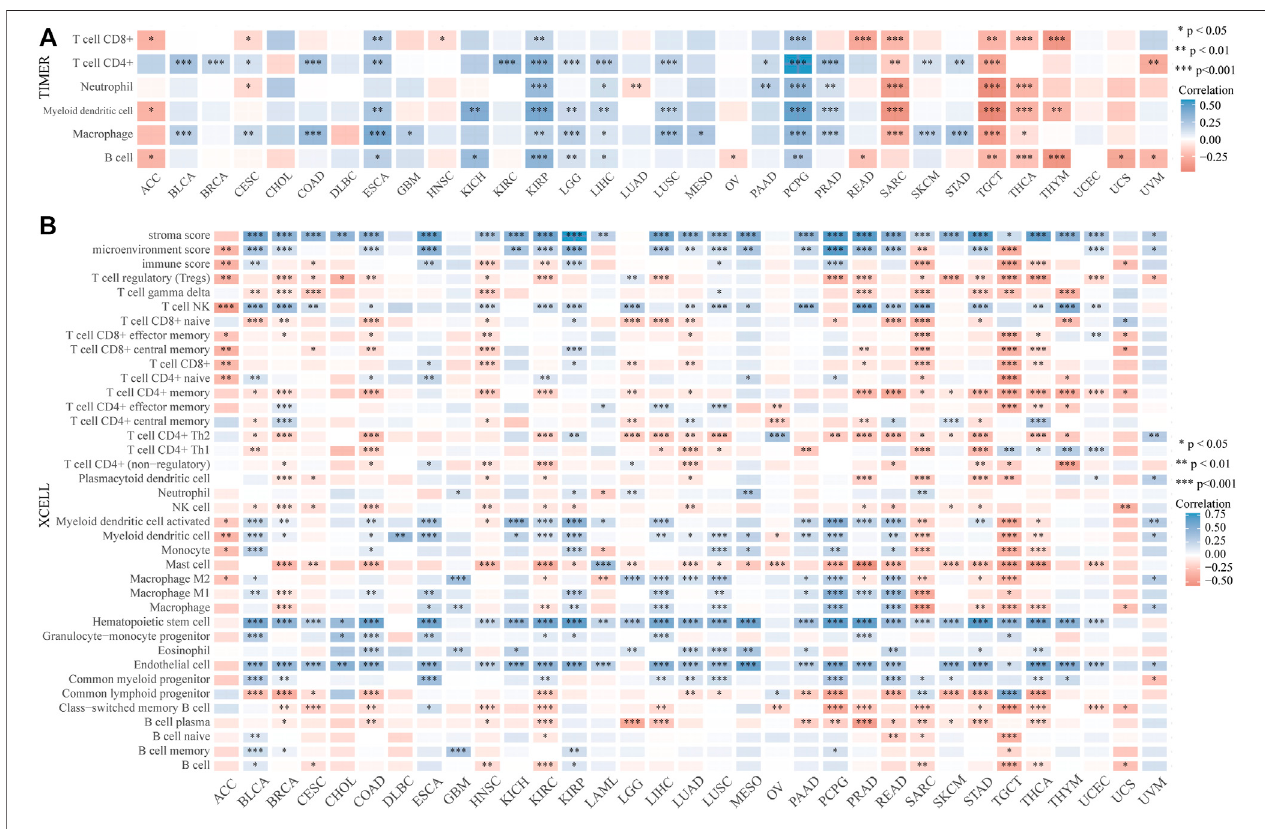
FIGURE 11 | PPP1R14A expression correlated with immune in fi ltration. The PPP1R14A expression signi fi cantly correlated with the in fi ltration levels of various immune cells in different tumors based on TIMER (A) and XCELL (B)